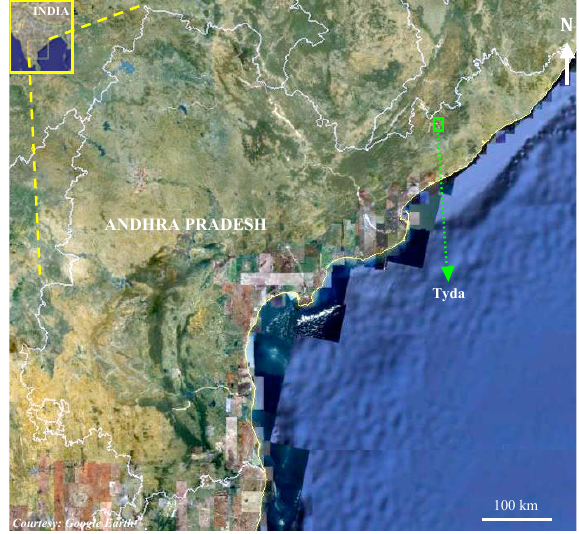
Image 1. Satellite image showing map depicting collection Image 1: Satellite image showing map depicting collection site of Hemidactylus cf. site of Hemidactylus cf. frenatus. frenatus.